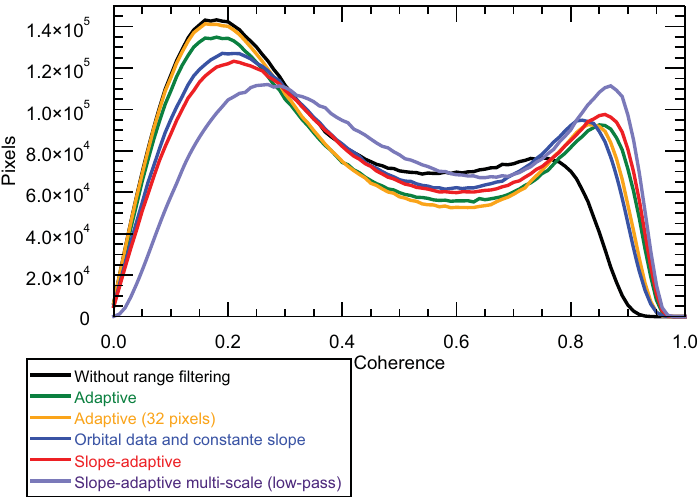
Figure 12. Coherence histograms after range filtering.